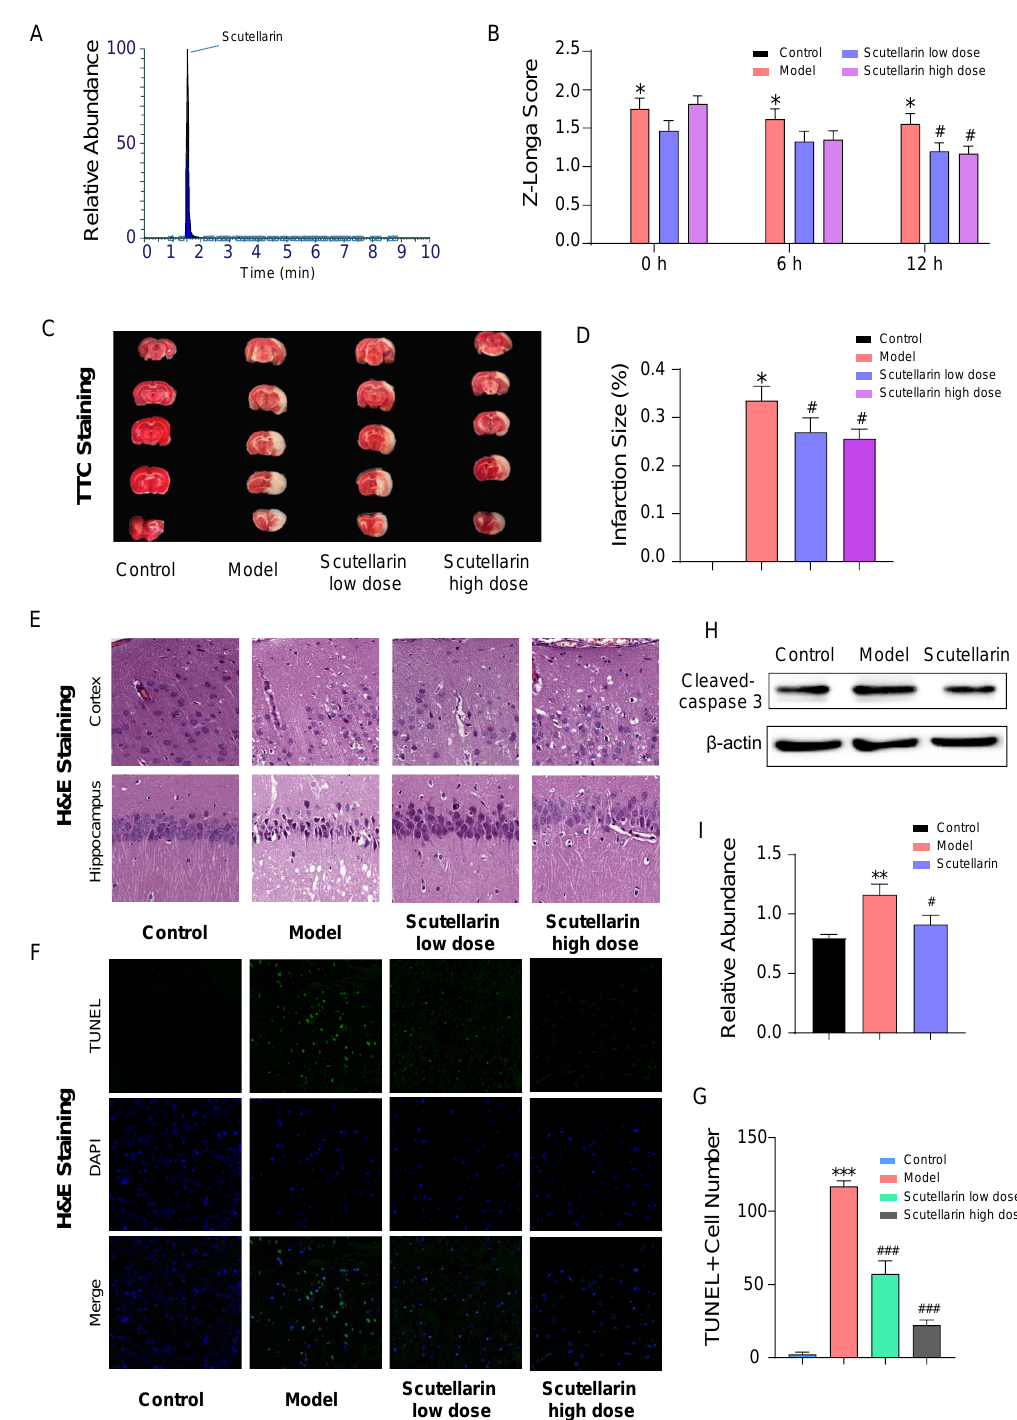
Figure 1. Protective effect of Scutellarin against acute ischemic injury in MCAO/R model rats. ( A ) The scutellarin used in this study is 98% pure. ( B ) Rat Z-Longa scores within 12 h after reperfusion. ( C , D ) TTC staining images ( C ) and infarction size ( D ) of rat brains at 12 h after reperfusion. ( E ) Scutellarin administration alleviates neuronal damage in both the cortex and hippocampus. ( F , G ) TUNEL staining illustrates that apoptotic cell numbers are significantly reduced upon scutellarin treatment. ( H , I ) The level of cleaved-caspase 3 in rats’ brain was down-regulated upon scutellarin treatment. Data are presented as mean ± SD , t -test, vs. control group: * p < 0.05, ** p < 0.01, *** p < 0.001 vs. model group: # p < 0.05, ### p <